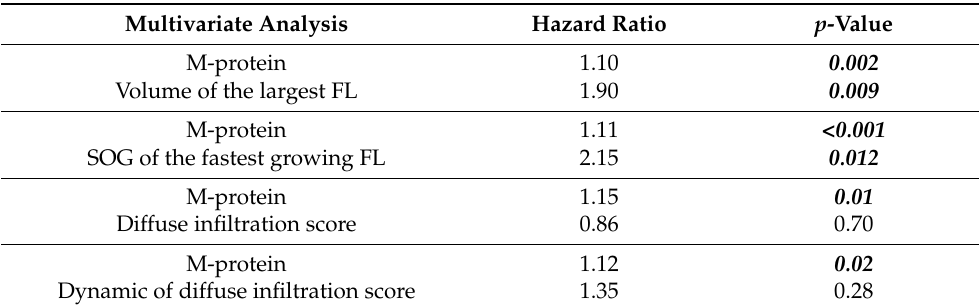
Table 2. Multivariate analysis of magnetic resonance imaging (MRI) parameters and baseline serum m-protein. SOG: speed of growth; FL: focal lesion. Significant findings are given in bold and italic letters.